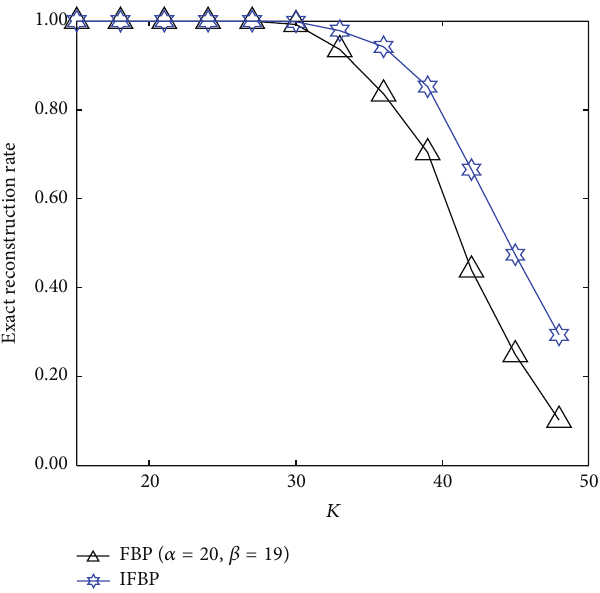
Figure 1: Exact recovery rates for the Gaussian sparse vectors ( 𝛼 = 20 , 𝛽 = 19 ).